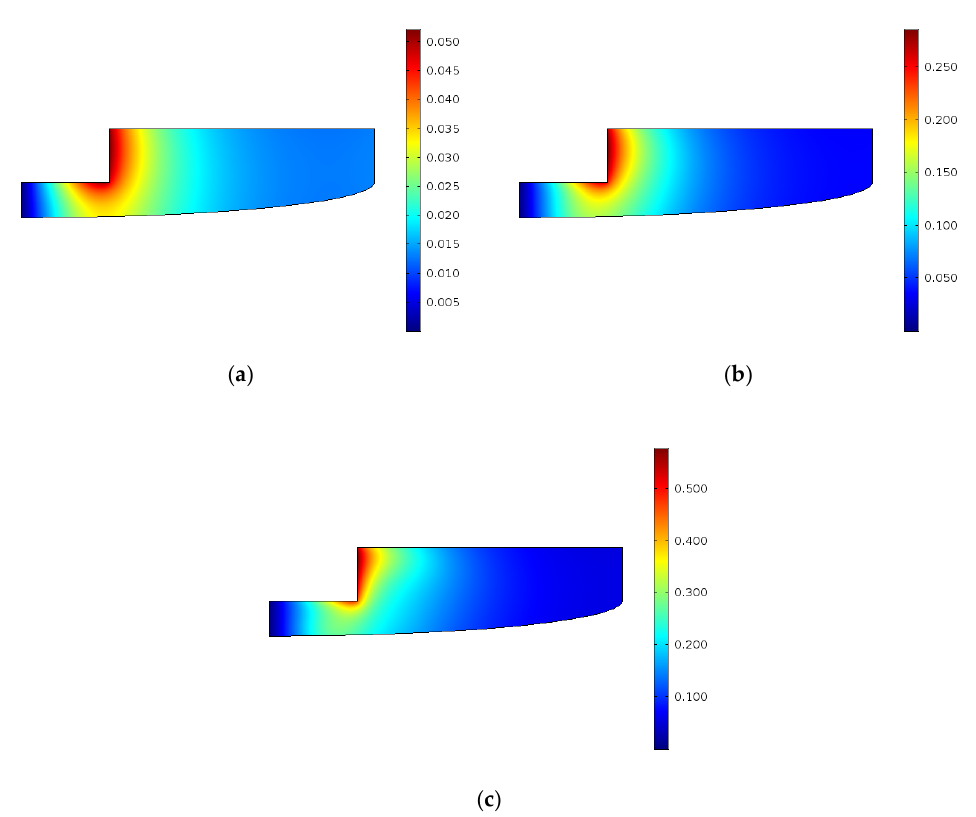
Figure 9. The sensitivity analysis of the revolution speed ( a ) 100 1/min; ( b ) 300 1/min; ( c ) 500 1/min.